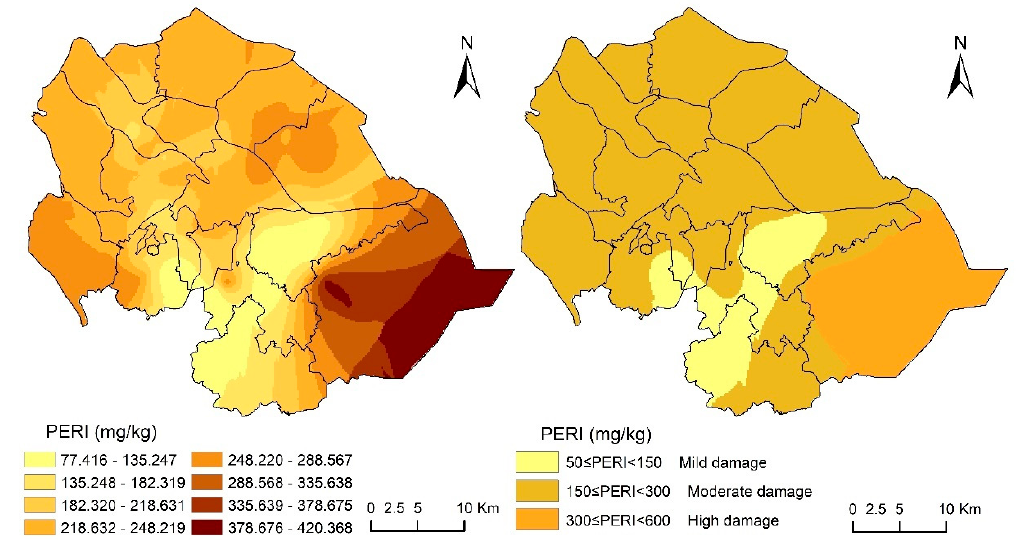
Figure 5. Spatial distributions of the comprehensive potential ecological risk index for eight elements in Zhongshan.